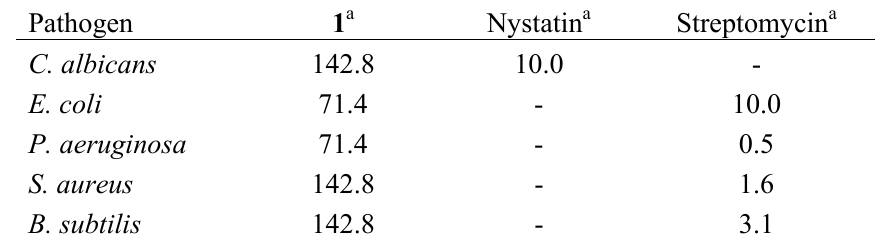
Table 1. Minimal Inhibitory Concentration (MIC) of 1 , Nystatin and Streptomycin toward Pathogenic Bacteria and